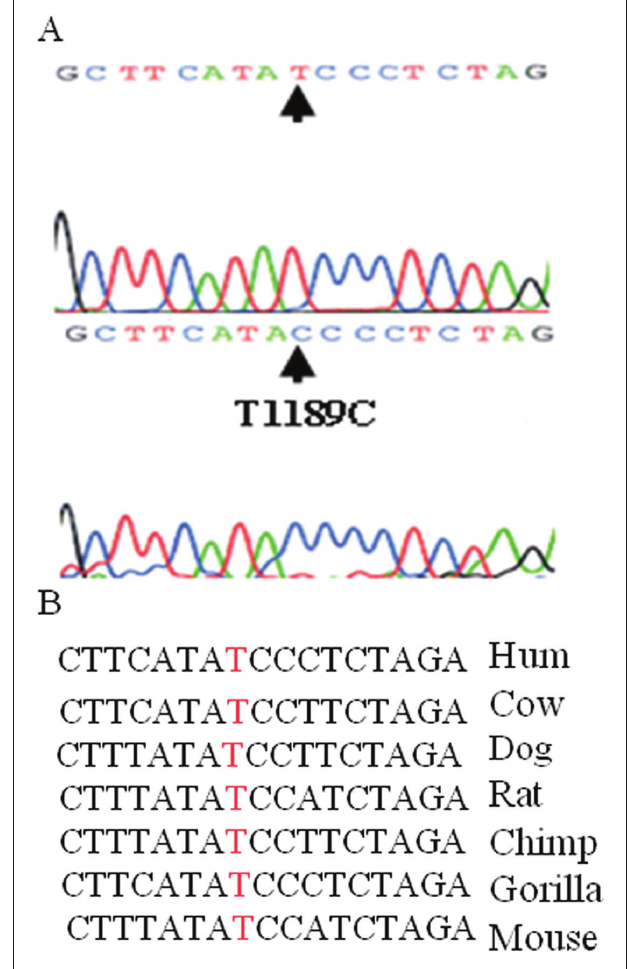
Figure 2. T1189C in 12S rRNA - (A) Partial chromatogram sequences of the 12S rRNA gene in T1189C carriers, and (B) Partial sequence alignment of the 12S rRNA gene in different species showing that the position 1189 is highly